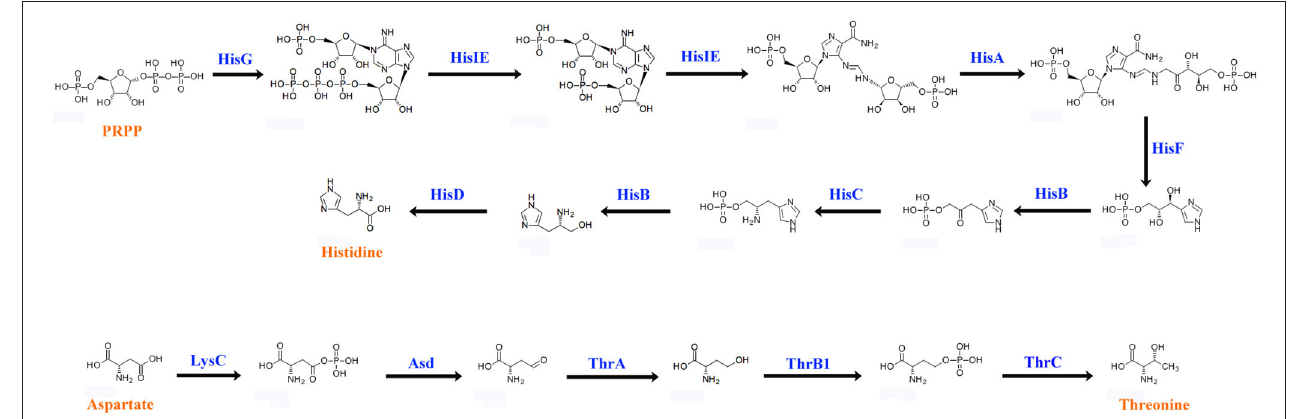
FIGURE 6 | Biosynthetic pathways of histidine and threonine by P. xylostella gut bacteria. The blue words above the arrow lines representing the enzymes of amino acid biosynthesis that identified from the